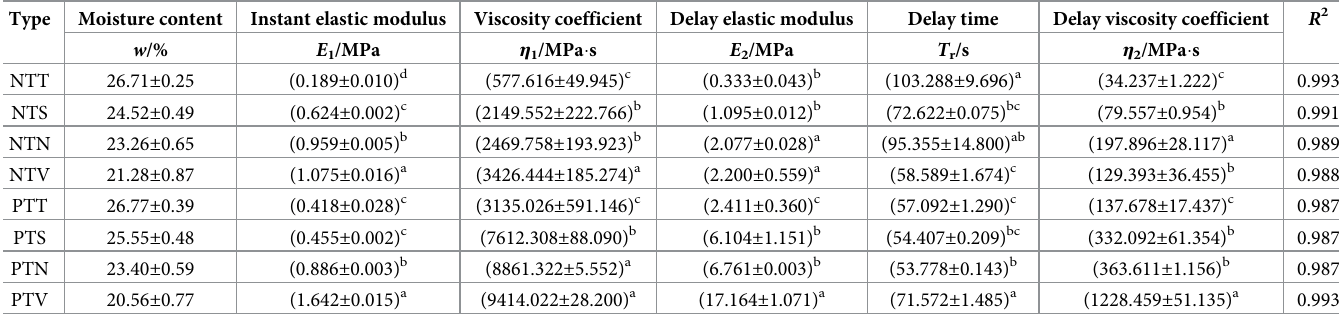
Table 2. Fitting parameters of creep model for no tillage paddy soil.